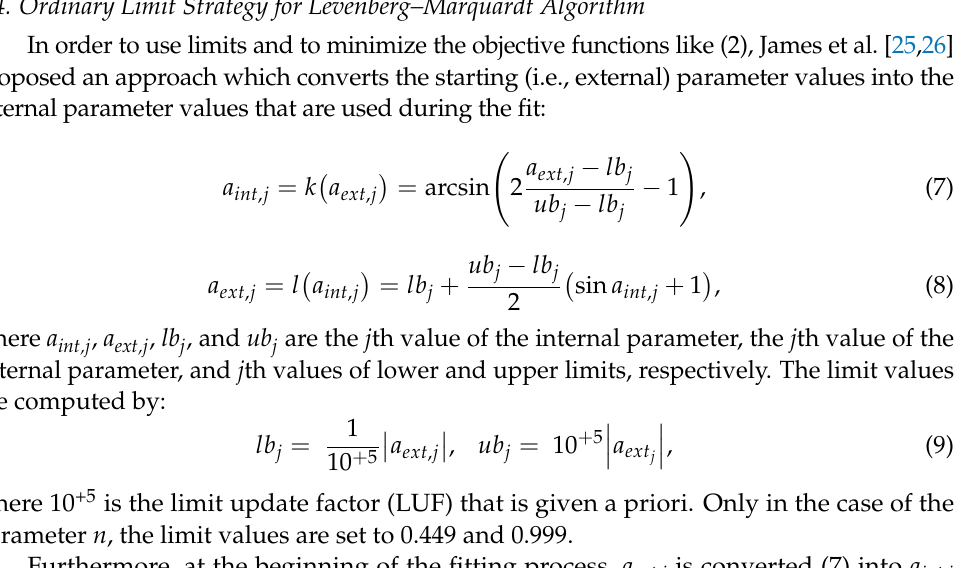
Table 1. Limit strategies coupled with Levenberg–Marquardt algorithm in EIS study. Limit Strategy Automatic Limits Update No limit No Ordinary No